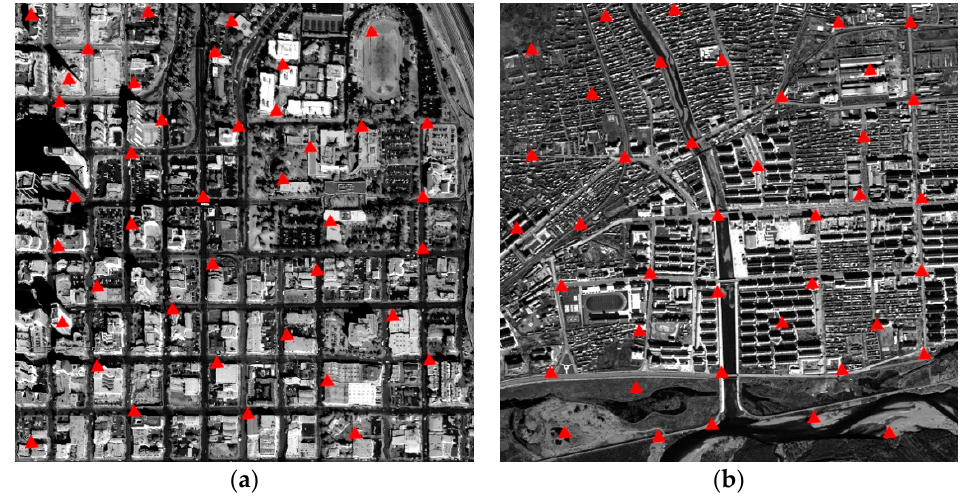
Figure 17. Check-point distribution in: ( a ) the first study area; and ( b ) the second study area.